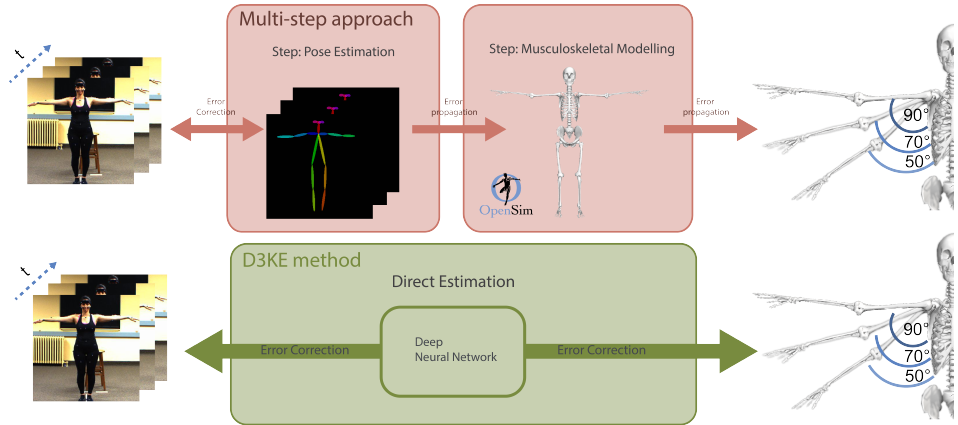
Figure 1. Overview of the proposed direct 3D human kinematics estimation (D3KE). Instead of using the common ’multi-step’ approach of predicting pose, fitting it to a model, and estimating kinematics, our D3KE directly estimates the kinematics. Errors in earlier steps of the multi-step approach propagate to later steps; in contrast, our method can correct for errors occurring anywhere between input and